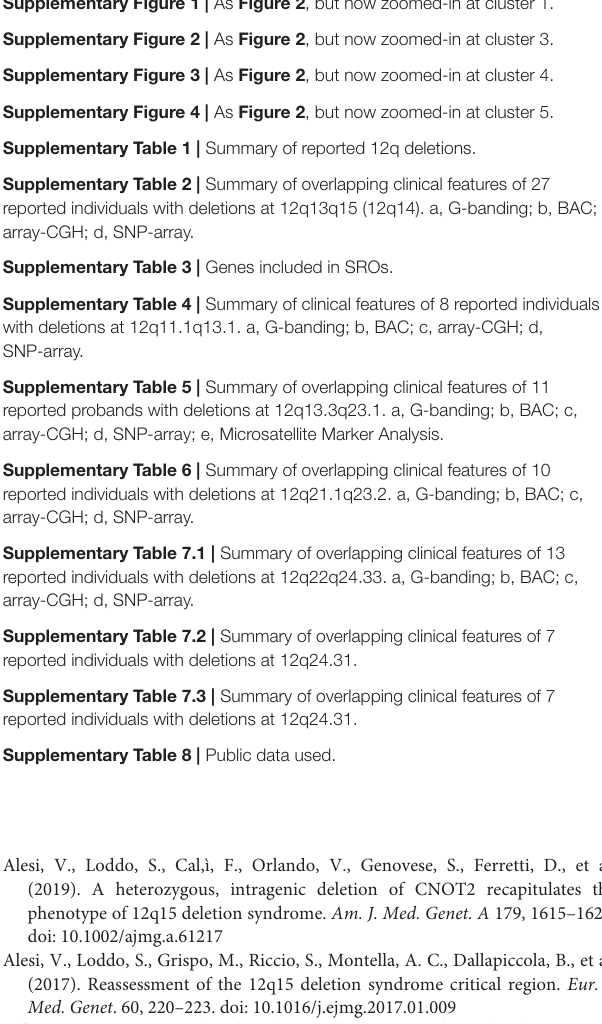
Supplementary Figure 1 | As Figure 2 , but now zoomed-in at cluster 1. Supplementary Figure 2 | As Figure 2 , but now zoomed-in at cluster 3. Supplementary Figure 3 | As Figure 2 , but now zoomed-in at cluster 4. Supplementary Figure 4 | As Figure 2 , but now zoomed-in at cluster 5. Supplementary Table 1 | Summary of reported 12q deletions.